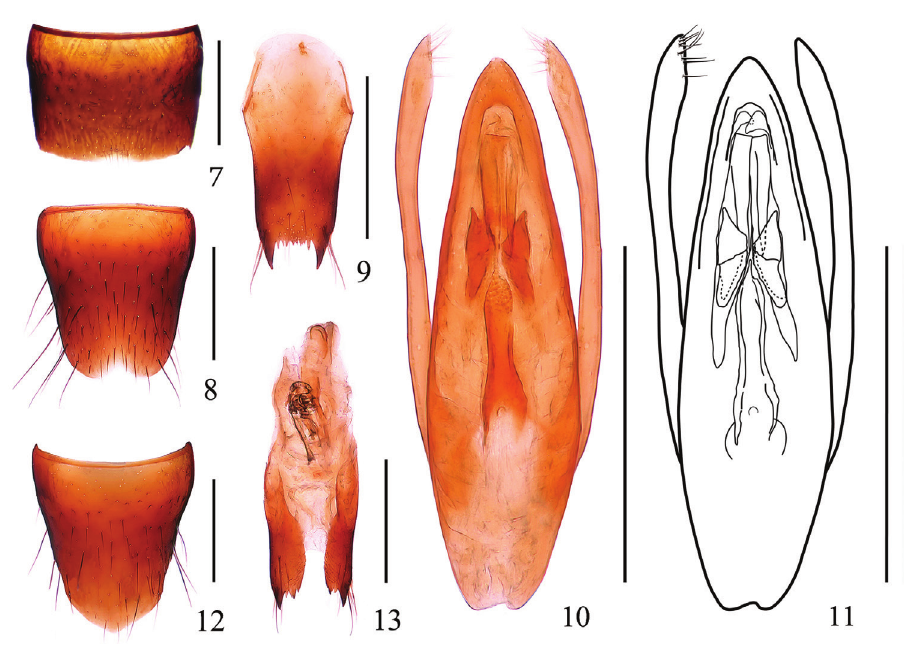
Figures 7–13. Stenus wuyanlingus . 7 male sternite VII 8 male sternite VIII 9 male sternite IX 10, 11 ae- deagus 12 female sternite VIII 13 valvifers and spermatheca. Scale bars: 0.25 mm.